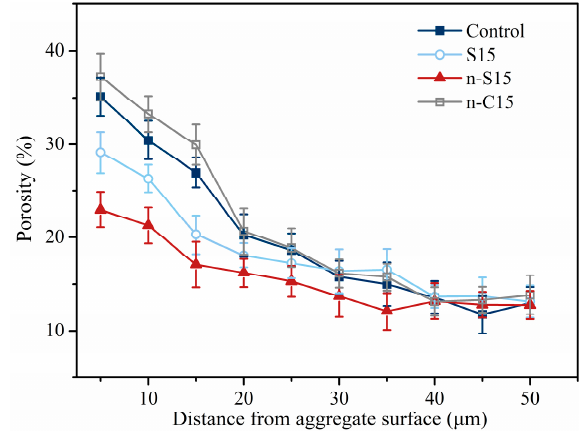
ff ect of coating particles on the porosity distribution within the Figure 12. Effect of coating particles on the porosity distribution within the ITZ. Figure 12. E